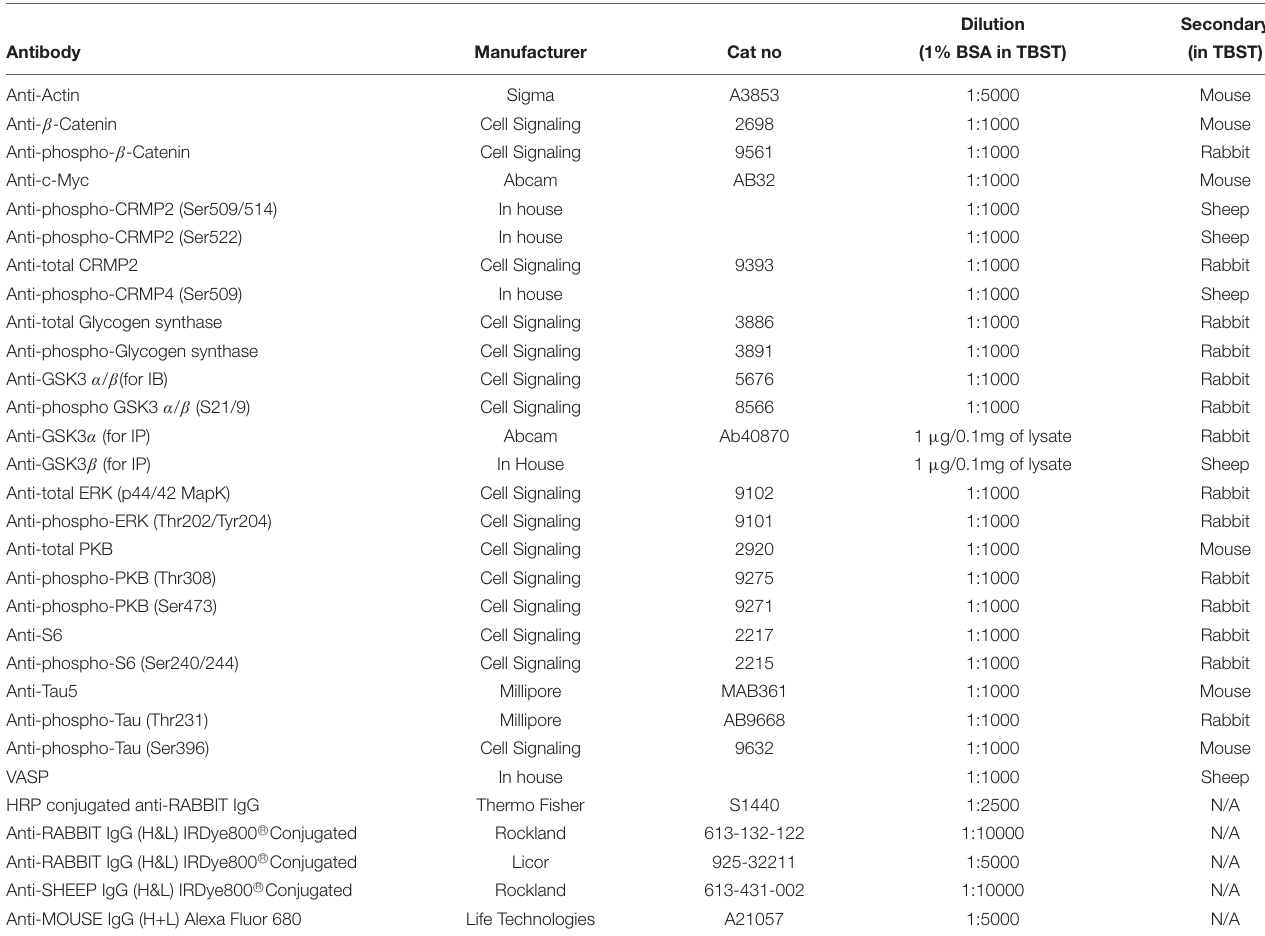
TABLE 2 | Antibodies used in this